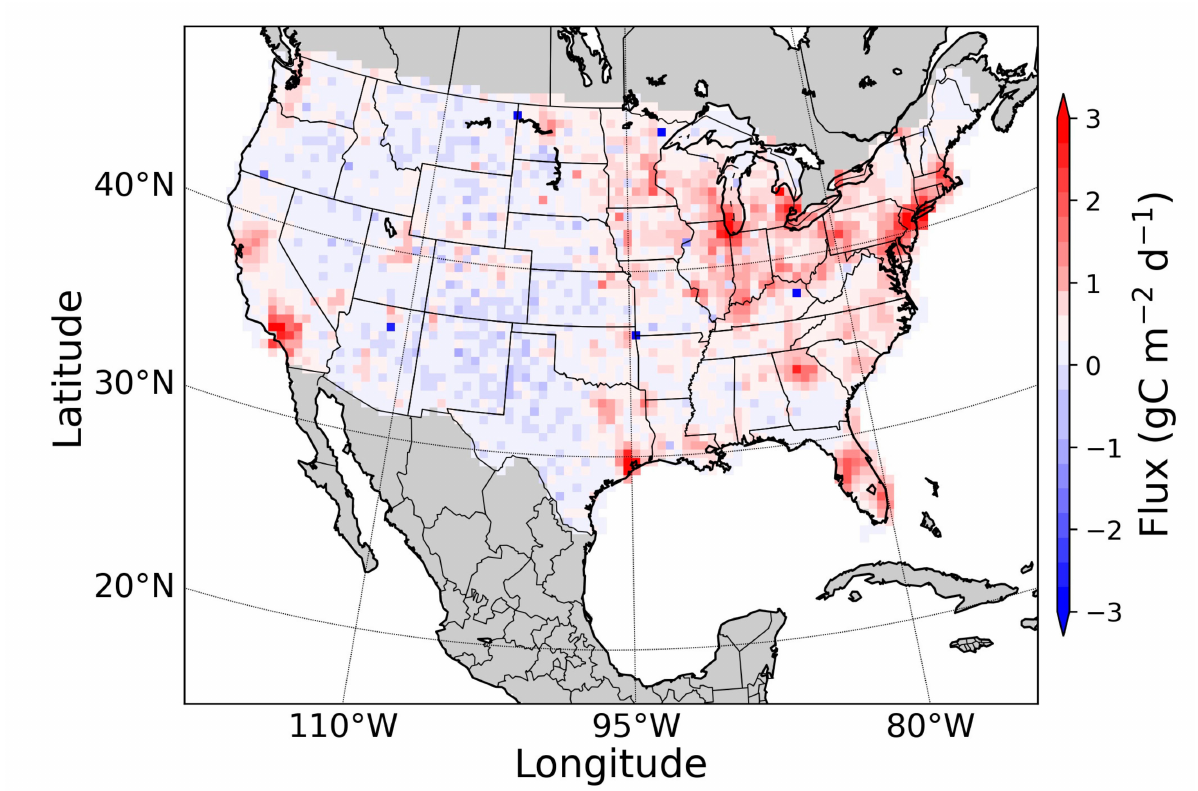
Figure 3. Spatial distribution of the annual mean posterior CO 2 flux estimated by the DA_FLUX experiment over the contiguous United States in